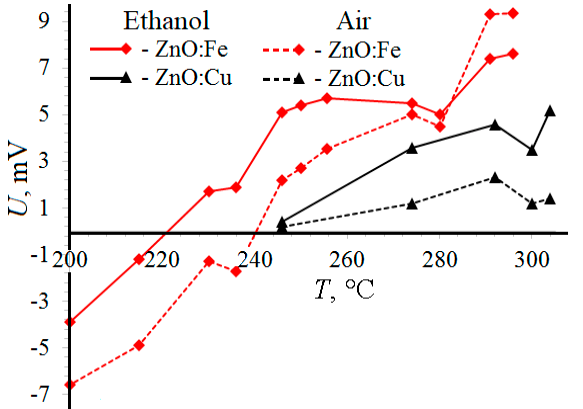
Figure 1. Temperature dependence of the electromotive force in ZnO/ZnO–Me structures with the upper layer formed by two immersions in an ethanol atmosphere of 1000 ppm.